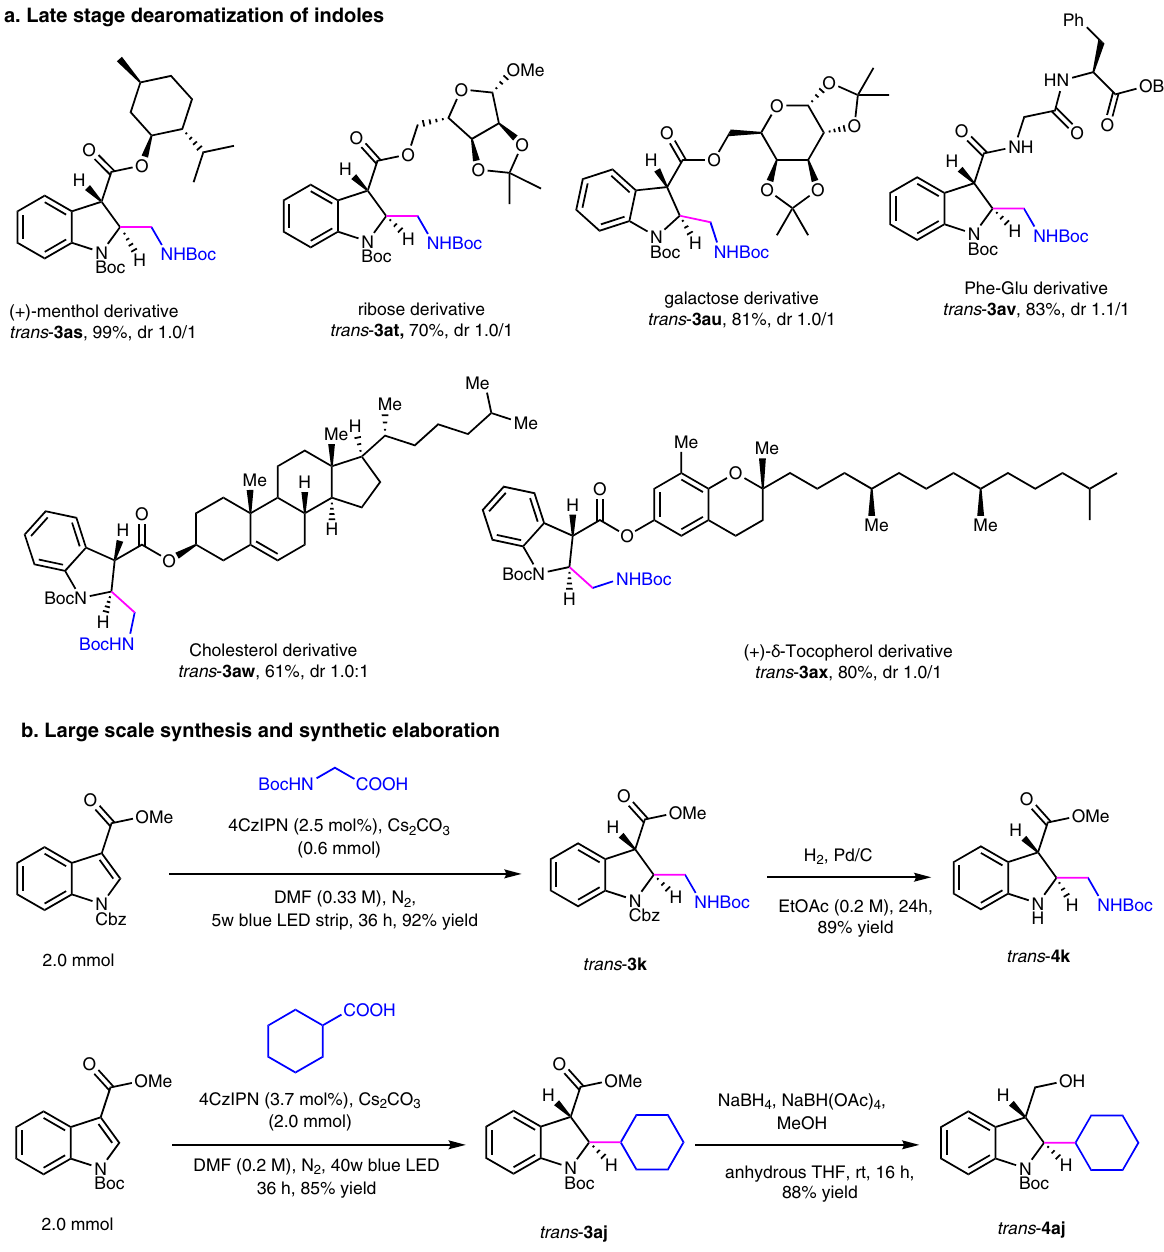
Fig. 4 Late-stage dearomatization of indoles and gram-scale synthesis of indolines. a Late-stage dearomatization of indoles. b Large scale synthesis and synthetic